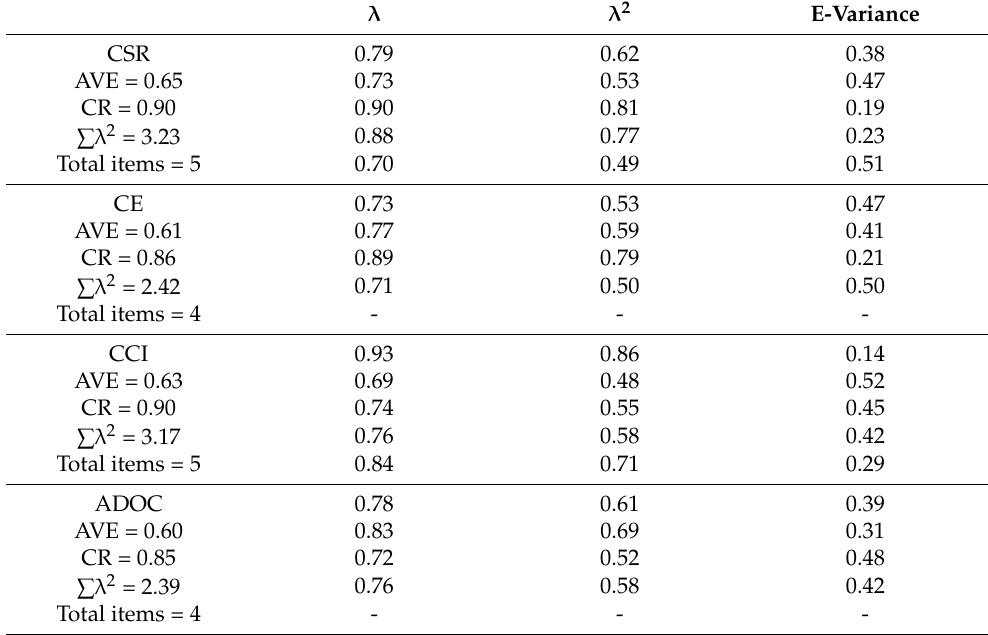
Table 3. Factor loadings of